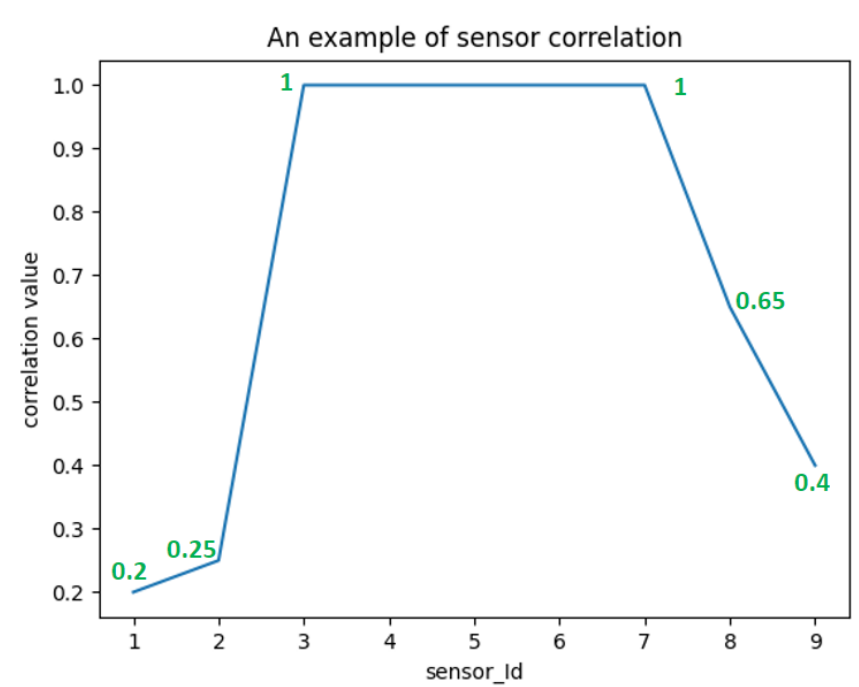
Figure 6. An example of sensor